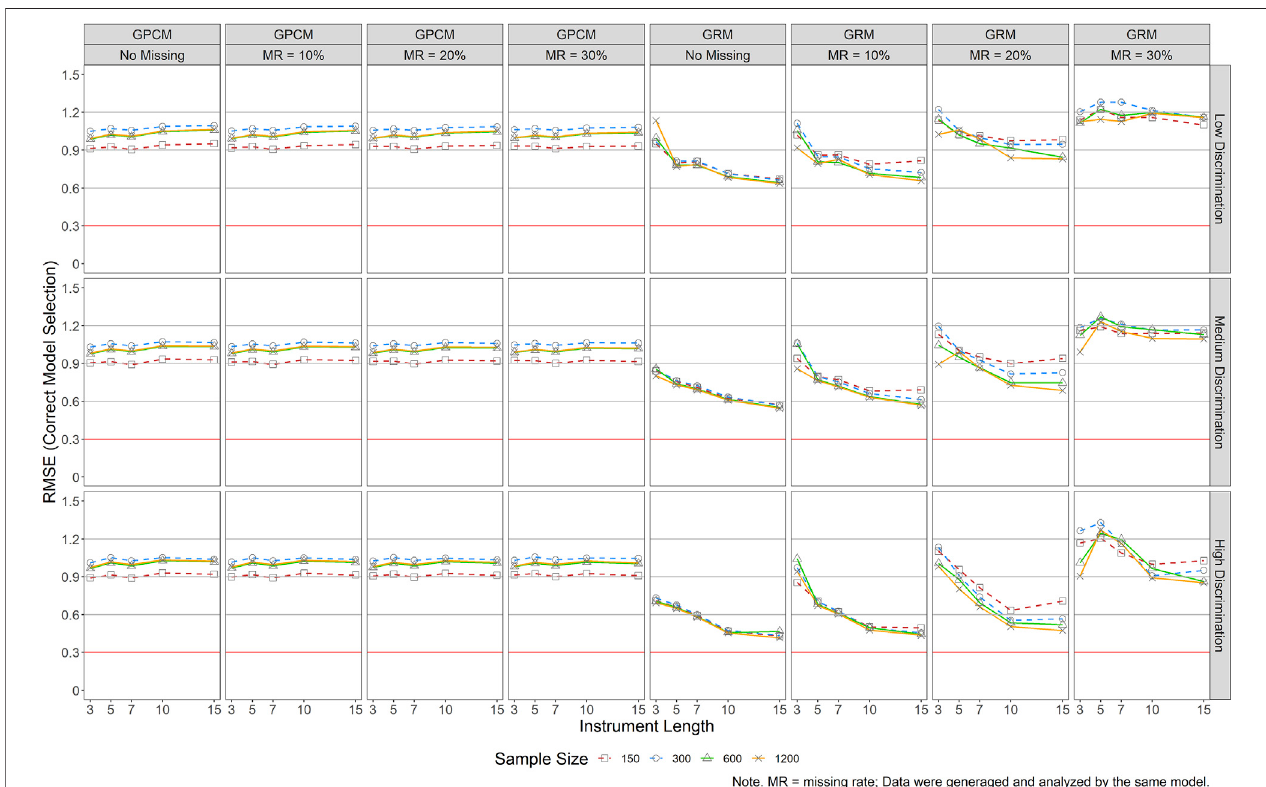
FIGURE 7 | RMSE Results of Person Parameter Estimations for Both GRM and GPCM (Correct Model Selection). Note. MR (cid:1) missing rate; Data were generaged and analyzed by the same